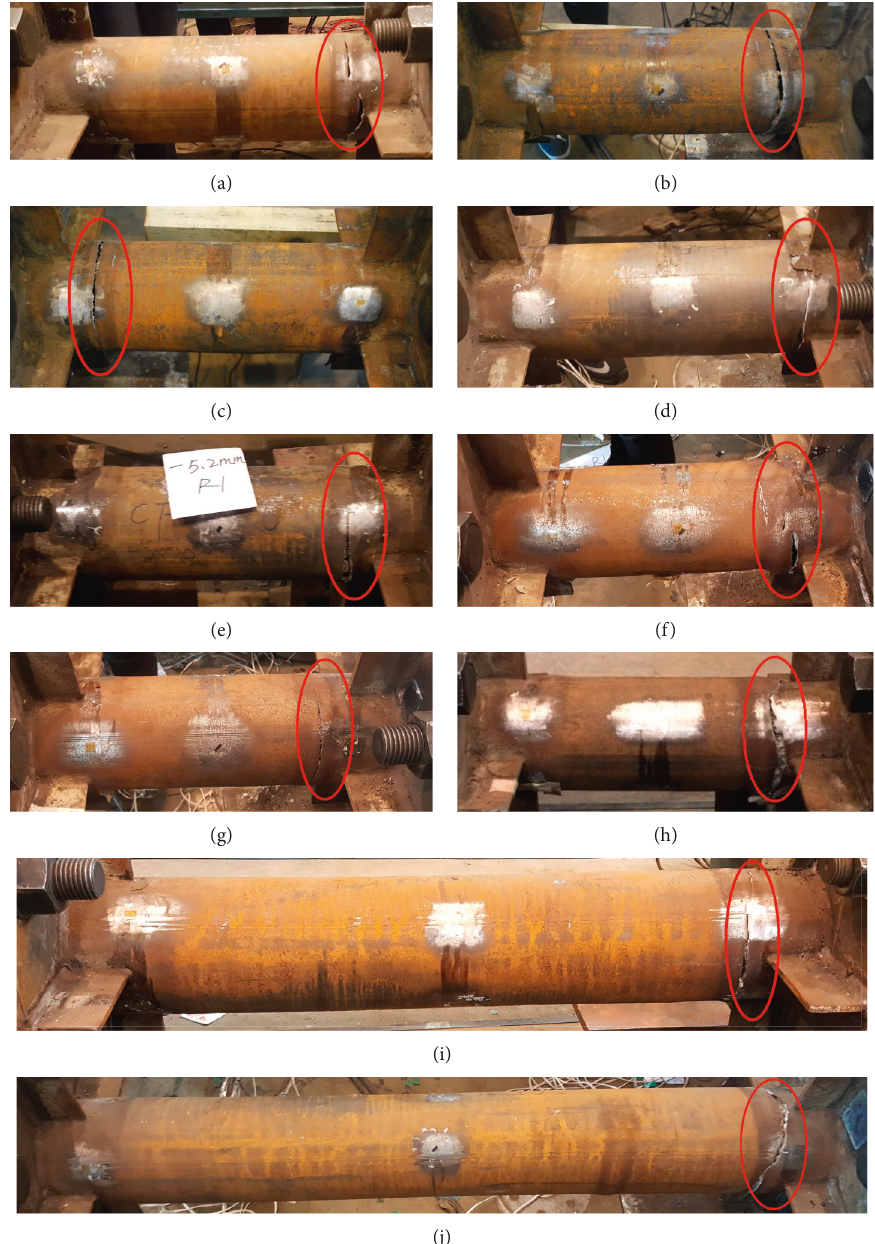
Figure 4: Specimens in failure. (a) HST-1; (b) CFST-2; (c) CFST-3; (d) CFST-4; (e) CFST-5; (f) HST-8; (g) CFST-9; (h) CFST-10; (i) CFST-6; (j)